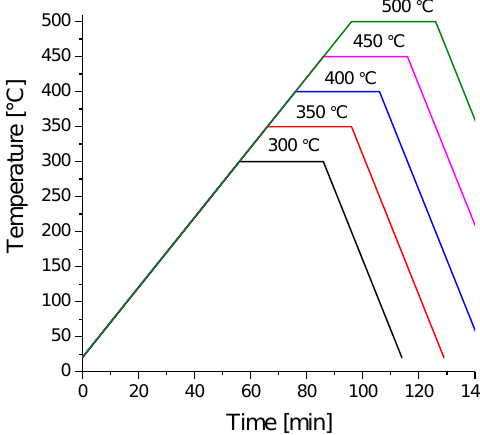
Figure 2. Programmed temperature profiles of the synthesis process.